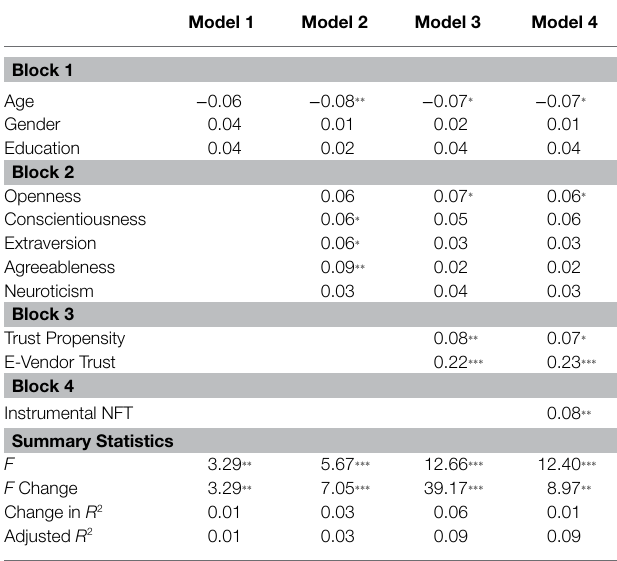
TABLE 4 | Results of the hierarchical regression models predicting willingness to purchase